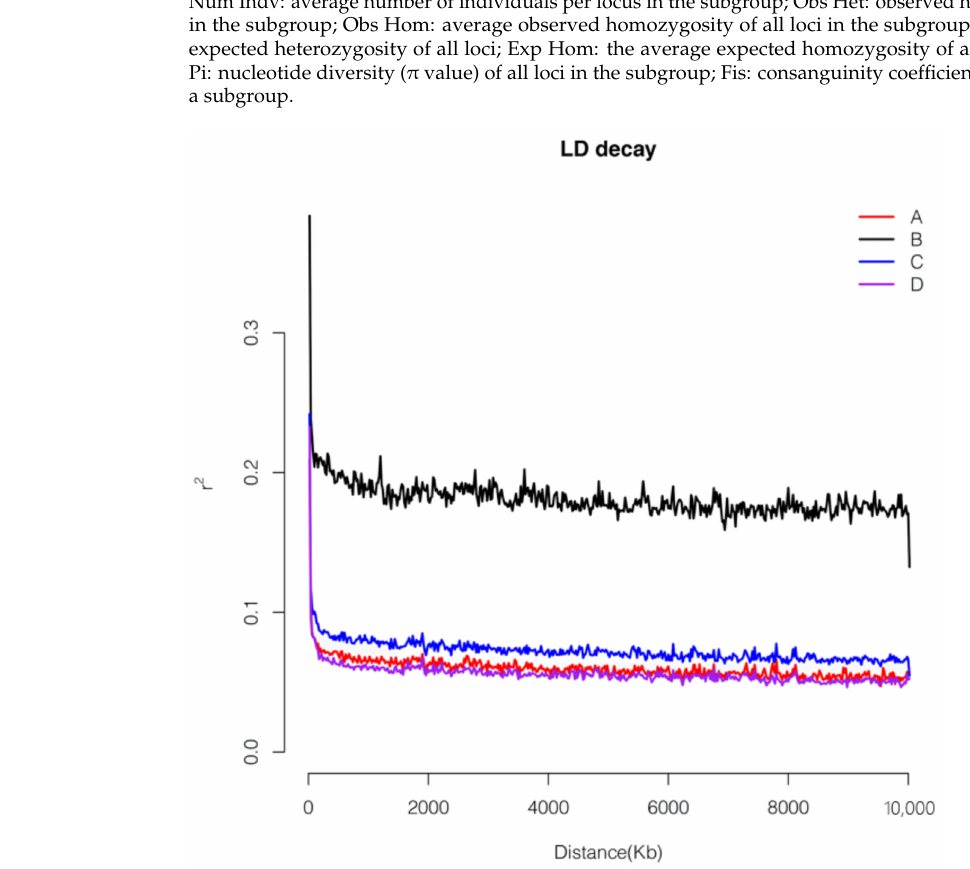
Figure 5. Linkage disequilibrium analysis. Abscissa: the clustering among SNPs; Vertical coordinate: r 2 , a higher r 2 curve indicates that the varieties has a stronger LD. Table 4. Population genetic differentiation